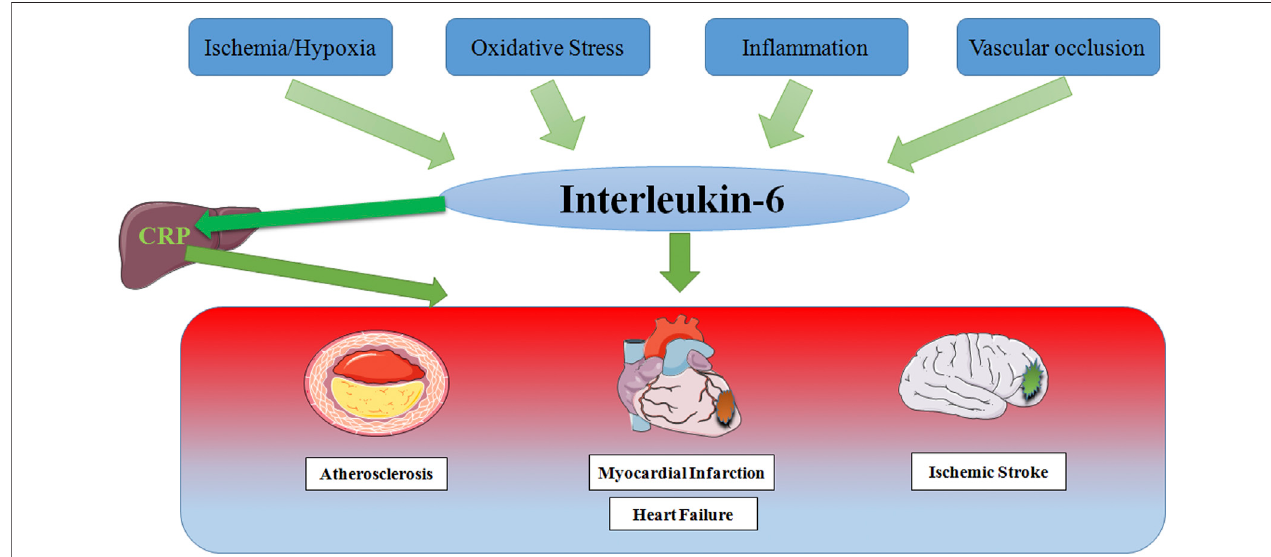
FIGURE4| SchematicrepresentationofriskfactorinducingIL-6inCardio-CerebrovascularDisease.Inresponsetostimulationbyischemiaandhypoxia,oxidative stress, in fl ammationand vascular occlusion, IL-6 levels are elevated, which partly leads to the production ofthe acute phase protein CRP in the liver, thereby stimulating leukocyte recruitment and thrombosis, ultimately causing multiple cardio-cerebrovascular diseases.